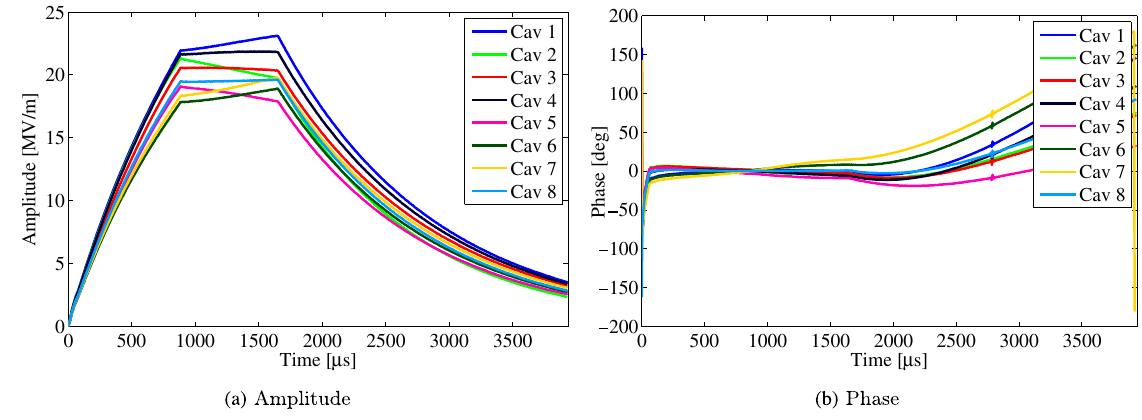
FIG. 9. The amplitude and phase of eight cavities with four IFs